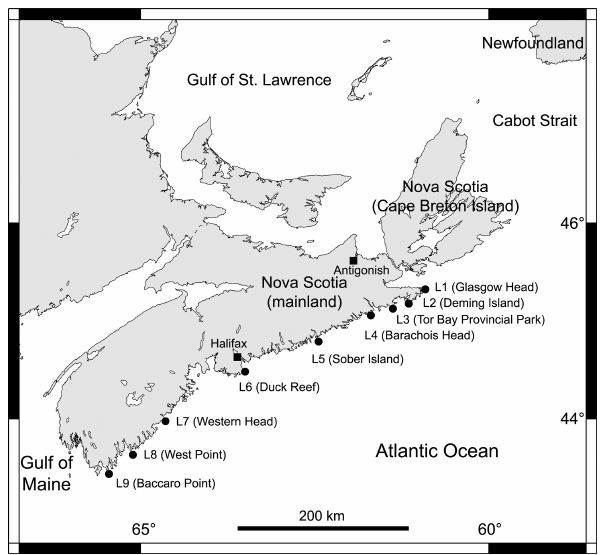
Figure 1. Map indicating the position of the nine wave-exposed intertidal locations surveyed along the Atlantic coast of mainland Nova Scotia,